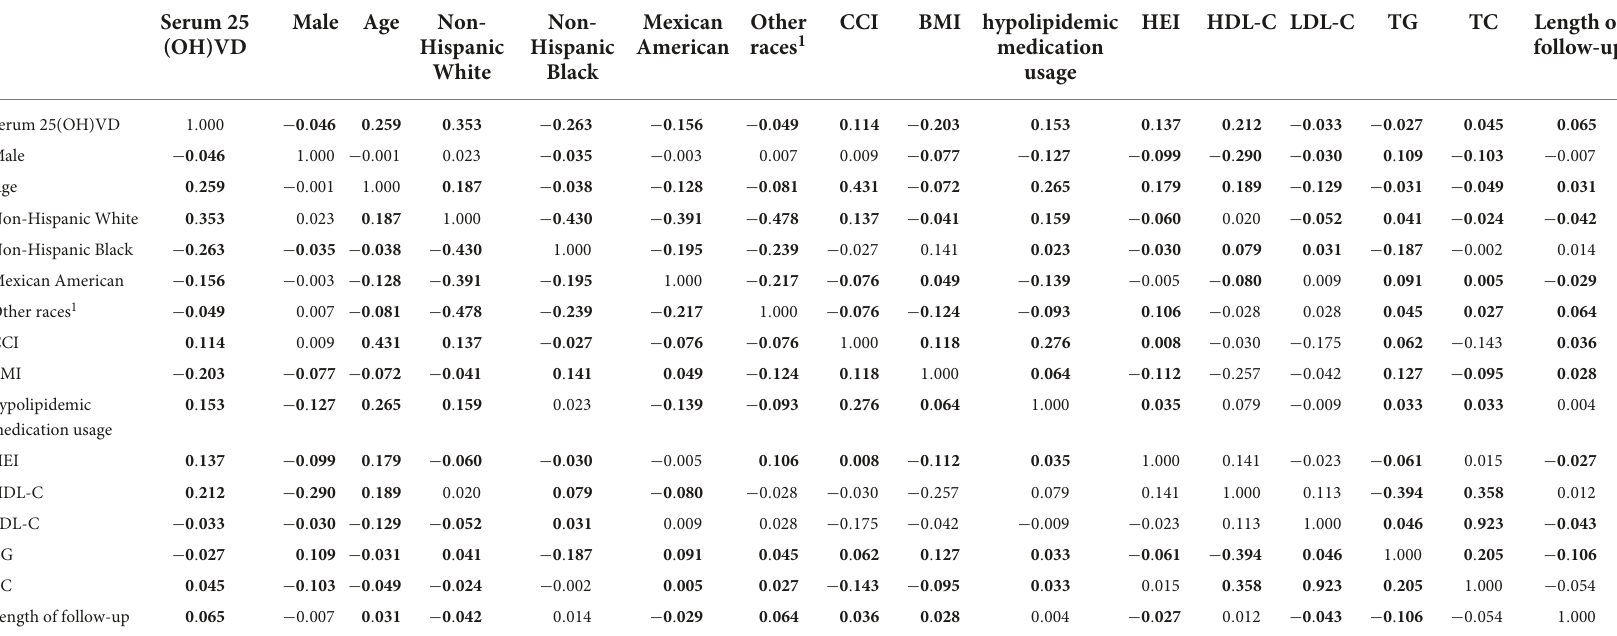
TABLE 2 The correlation coefficients between variables in the present